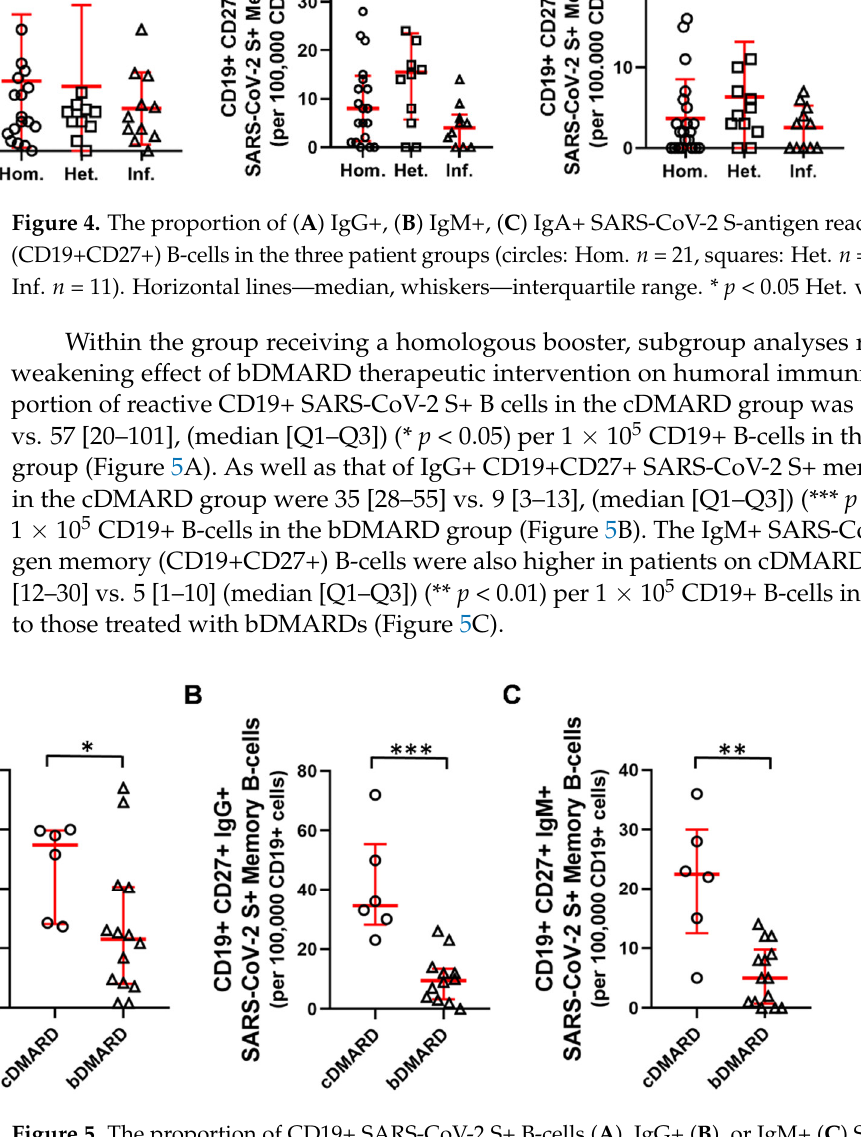
Figure 5. The proportion of CD19+ SARS-CoV-2 S+ B-cells ( A ), IgG+ ( B ), or IgM+ ( C ) SARS-CoV-2 S antigen reactive memory (CD19+CD27+) B-cells within patients receiving a homologous booster split according to their medication. Horizontal lines—median, whiskers—interquartile range. (cir- cles: cDMARD n = 6, triangles: bDMARD n = 15). * p < 0.05; ** p < 0.01; *** p < 0.001.